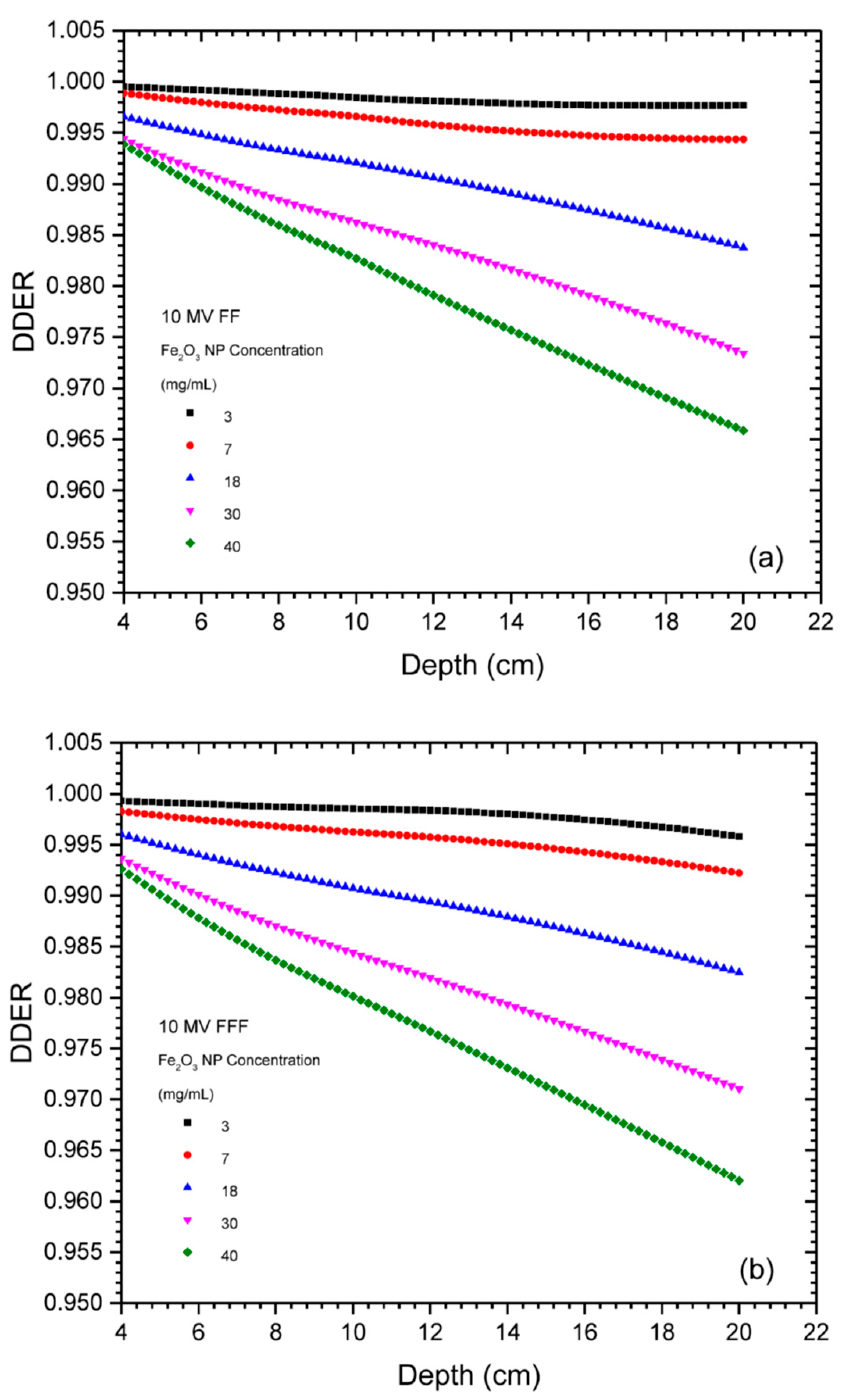
Figure 2. DDER vs. depth for different Fe 2 O 3 NP concentrations using the ( a ) 10 MV FF and ( b ) 10 MV FFF photon beams.